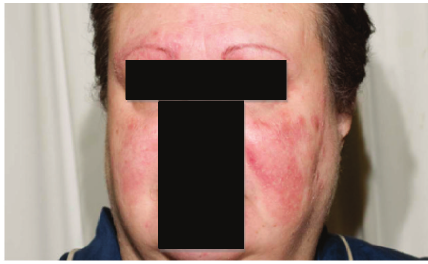
Figure 1: Pretreatment extent of clinically apparent disease.